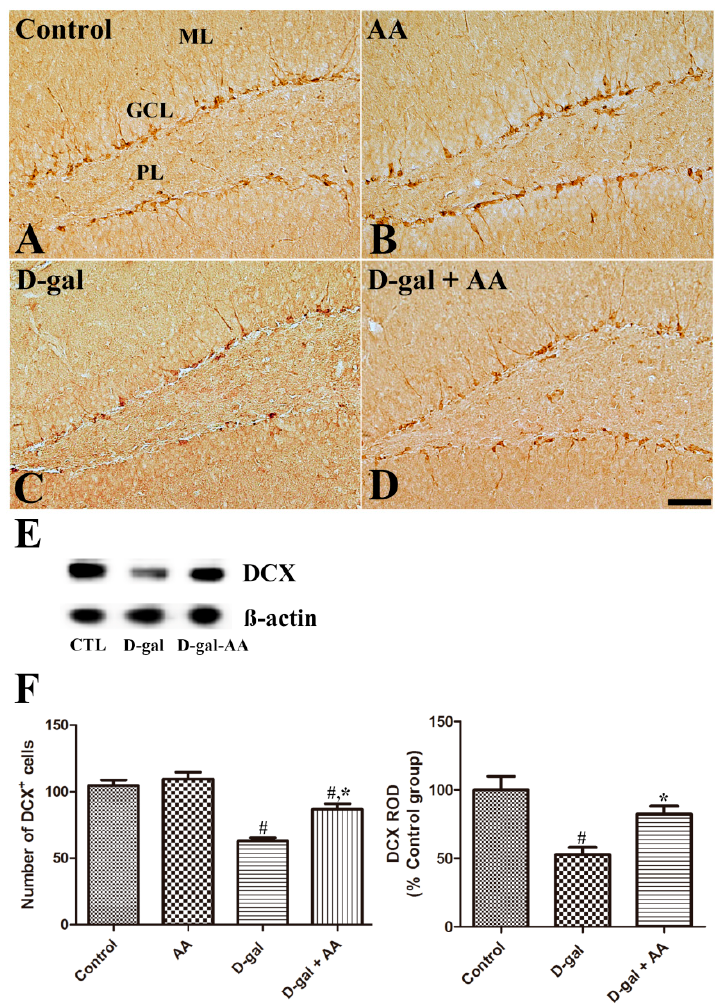
Figure 3. Immunohistochemistry for doublecortin (DCX) in the dentate gyrus in control (CTL) ( A ), ascorbic acid (AA) ( B ), D-galactose (D-gal) ( C ), and ascorbic acid (150 mg / kg)-fed D-gal ( D ) groups. Cell bodies of DCX-positive neuroblasts are located in the subgranular zone of the dentate gyrus, and their dendrites extend in the ML of the dentate gyrus. The number of DCX-positive neuroblasts decreases, and the dendritic complexity is impaired in the D-gal group compared with the control group. Note that ascorbic acid administration significantly increases the number of DCX-positive neuroblasts, and DCX-positive neuroblasts show well-developed dendrites in the D-gal + AA group compared with the D-gal group. GCL, granule cell layer; ML, molecular layer; PL, polymorphic layer. Scale bar = 50 μ m. ( E ) Western blot analysis of DCX in the hippocampus in control, D-gal, and D-gal + AA groups. ( F ) The number of DCX-positive neuroblasts in the dentate gyrus. The relative optical density (ROD) of immunoblot bands is expressed as a percentage of the value of the control group ( n = 10 per group for immunostaining, n = 7 per group for immunoblotting; # p < 0.05, indicating a significant difference compared with the control group; * p < 0.05, indicating a significant difference compared with the D-gal group). Data are presented as means ± SEM.